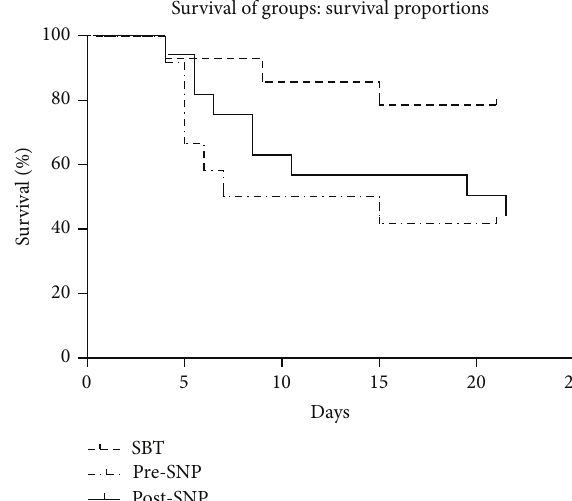
Figure 2: Survival Curve of three groups : a significantly lower mortality rate in the pre-SNP group ( 𝑛 = 14 ) compared to that in SBT group ( 𝑛 = 12 ) and post-SNP group ( 𝑛 = 16 ) during 3 weeks of observation ( 𝑃 < 0.05 ).